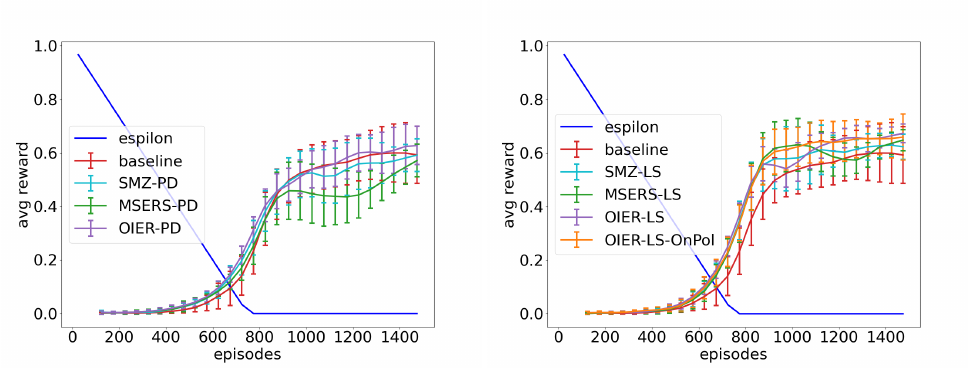
Figure A11. The results for state encoding: LKE. IER mode: PD and t expl = 1000. IER mode: LS and t expl = 500.